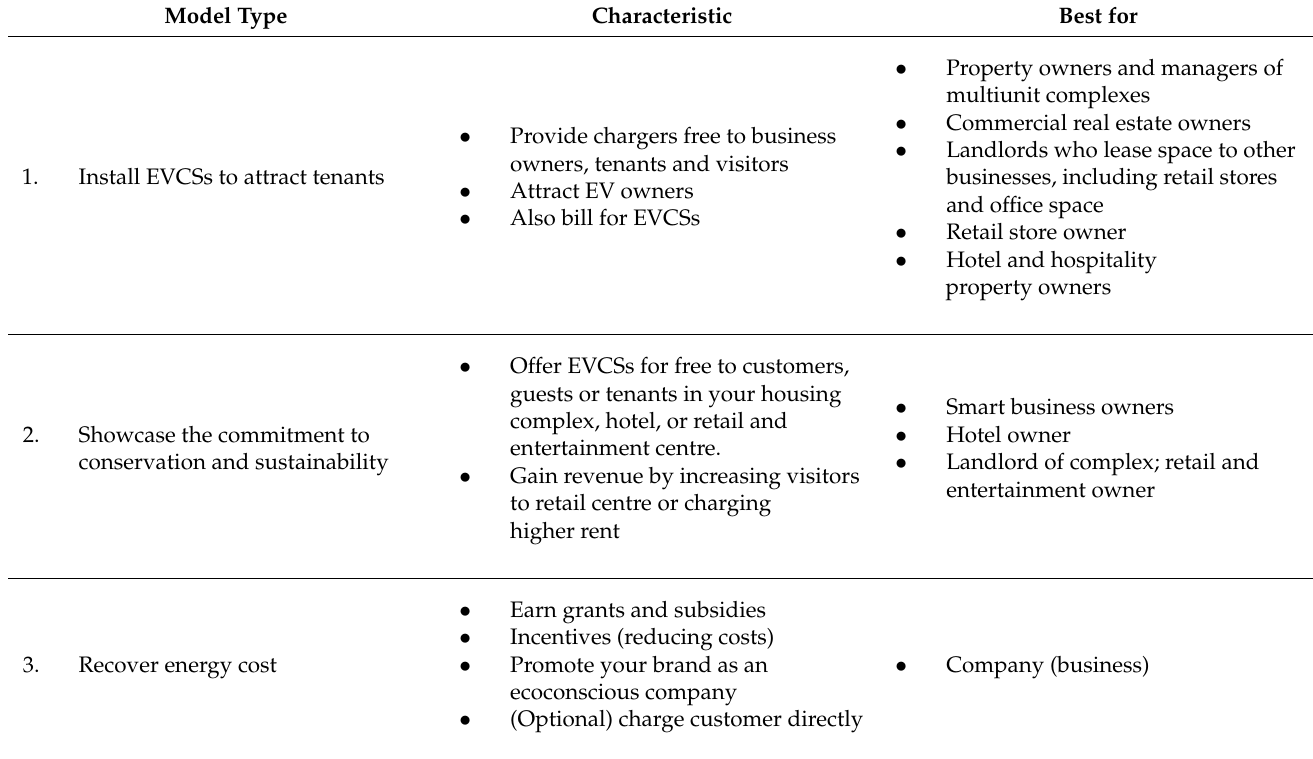
Table 3. Three EVCS business models